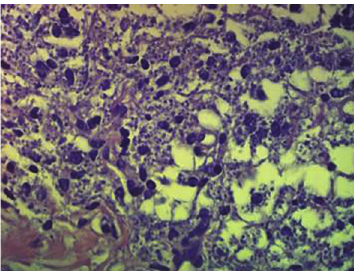
Figure 4: Photomicrography showing granulomatous panniculitis with high number of Leishmania amastigotes (Hematoxylin and Eosin stain, x400).